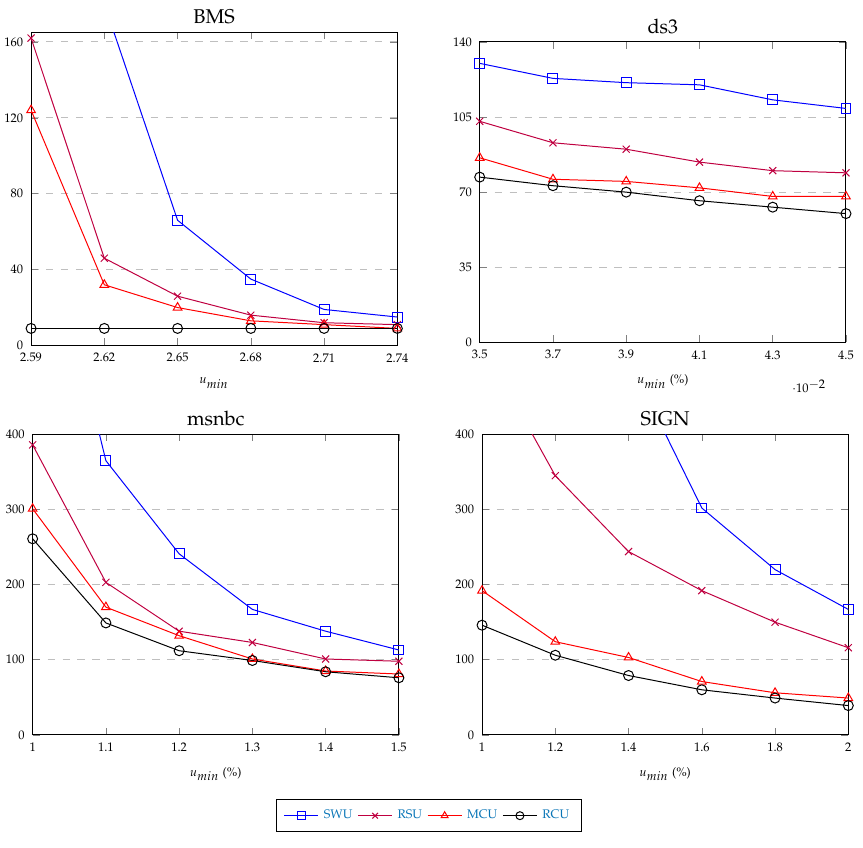
Figure 9. Results of experiment 1: Time (s) taken by each method to identify the full set of high utility sequential patterns.